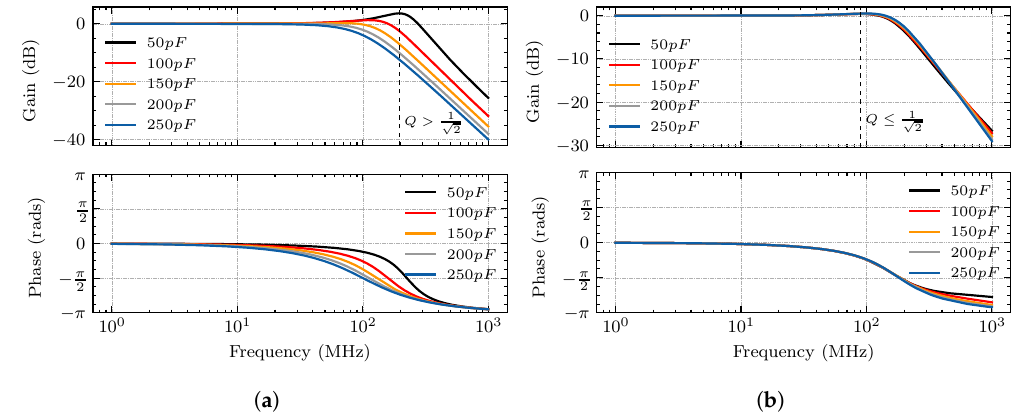
Figure 5. Simulated frequency responses of traditional and innovative TEV sensors at different mutual capacitances. ( a ) The sensitivity of the traditional TEV sensor greatly depends on mutual capacitance. ( b ) The sensitivity of the innovative TEV sensor is less dependent on mutual